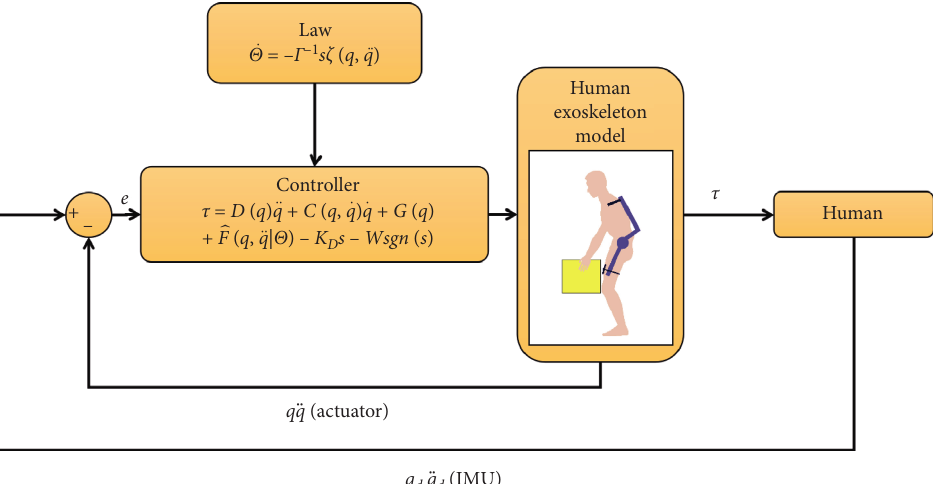
Figure 8: The block diagram of robust fuzzy adaptive control of human exoskeleton system.